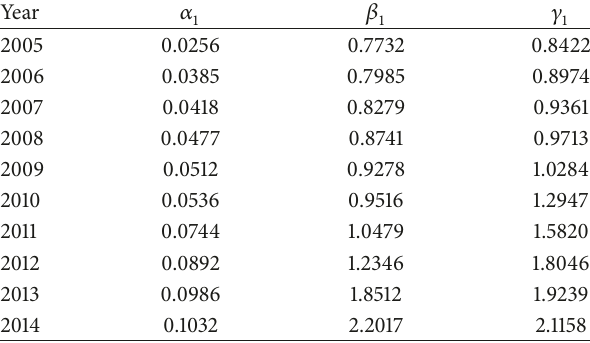
Table 2: Parameter value of Chinese industry-university-research collaborative innovation system evolution from 2005 to 2014.